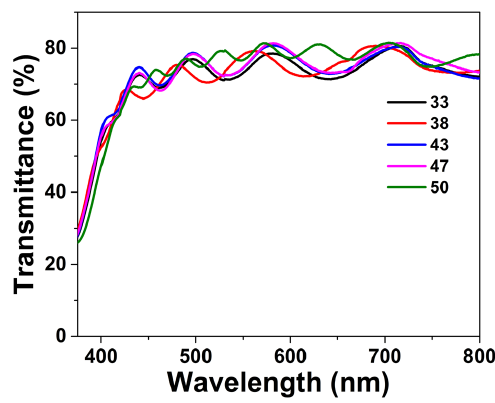
Figure 5. Transmittance spectra of AZO coatings prepared at different argon partial